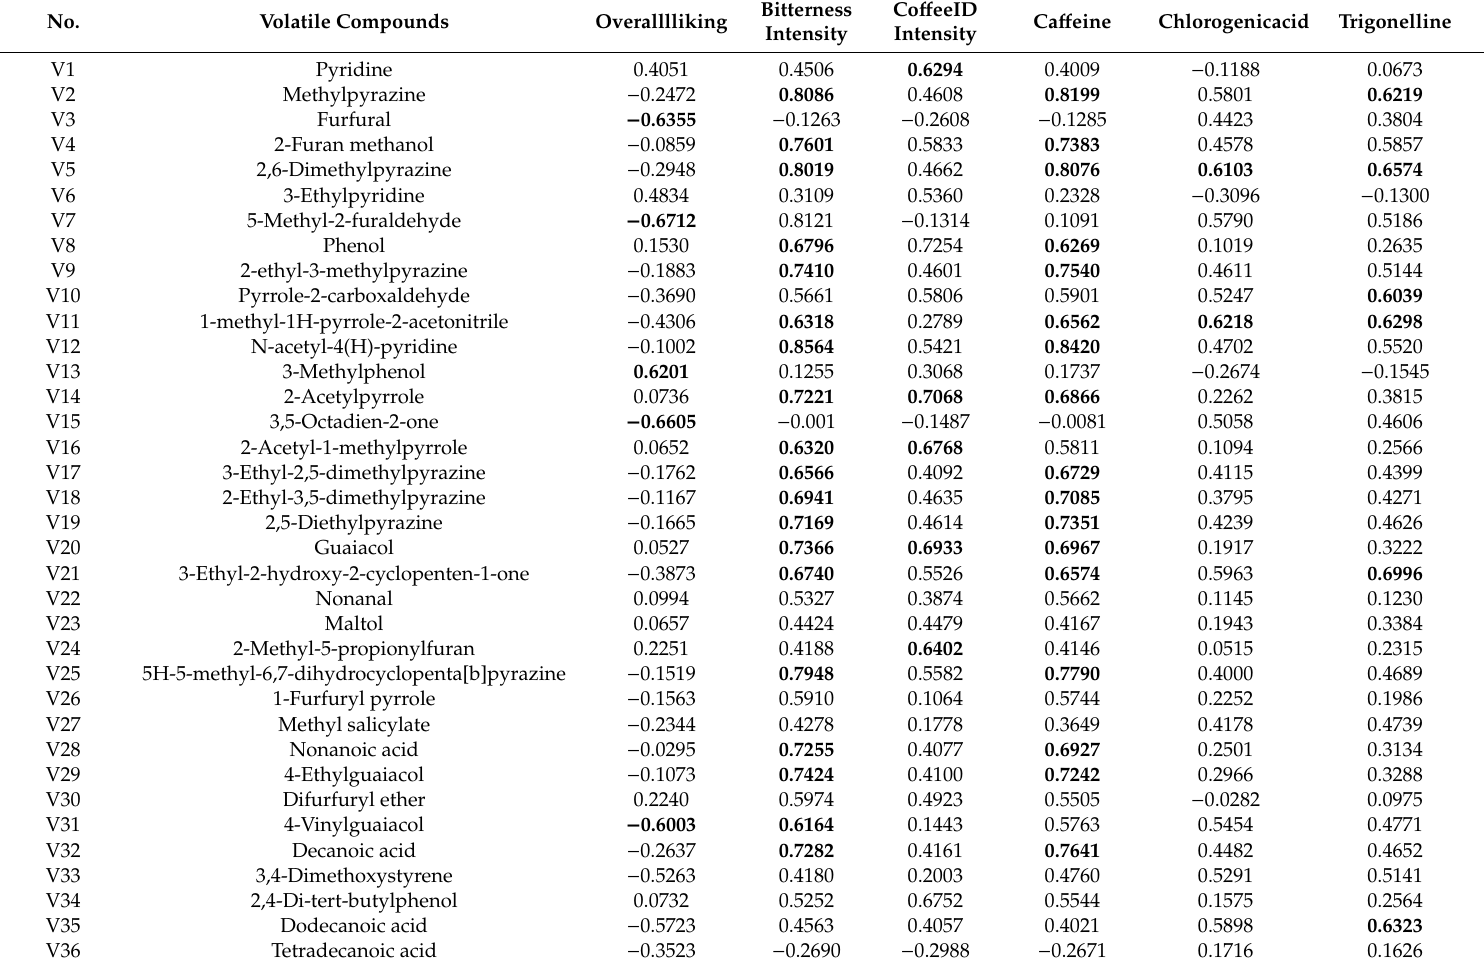
Table 9. Correlation matrix between volatile compounds and sensory data, ca ff eine, chlorogenic acid, and trigonelline compounds 1